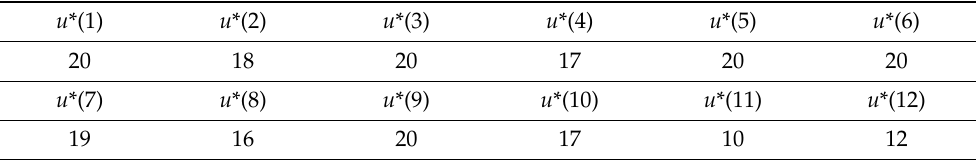
Table 3. Optimal production plan.